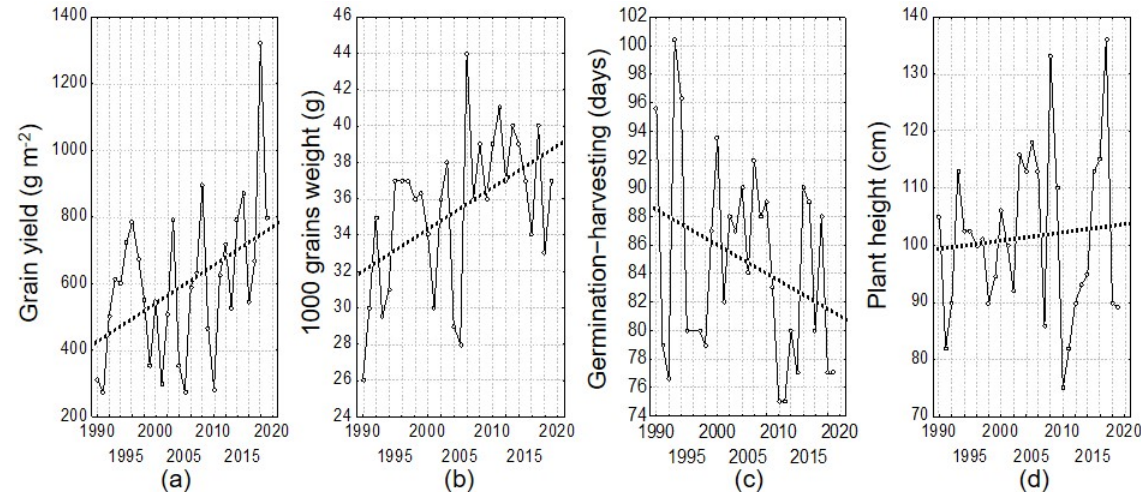
Figure 1. Dynamics of main agronomic characters in the oat cultivar ‘Gorizont’ in 1990–2019: ( a ) grain yield per 1 m 2 ; ( b ) 1000 grain weight; ( c ) length of the germination to harvesting period; ( d ) plant height.